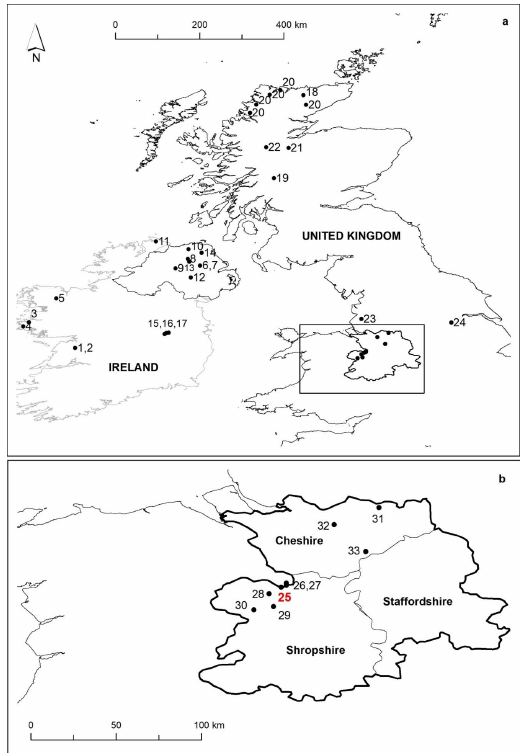
Figure 3. Locations of key palaeoecological studies undertaken on subfossil P. sylvestris in Britain and Ireland. ( a ) Sites in Ireland, Northern Ireland, Scotland, northern and eastern England. ( b ) Sites in the Meres and Mosses region (Shropshire — Cheshire — Staffordshire), including Wem Moss, site 25 (RED) — new dendrochronological data presented in this paper: 1 – 2 Aughrim Swamp, Rockforest Lough [59,60]; 3 – 5 Letterfrack, Derryeighter, Garrynagran [61]; 6 – 7 Sluggan, Sharvogues [62 – 64]; 8 Fallahogy [62]; 9 Ballynagilly [,65,66]; 10 Garry Bog [62]; 11 Drumaville [D Brown pers. comm.]; 12